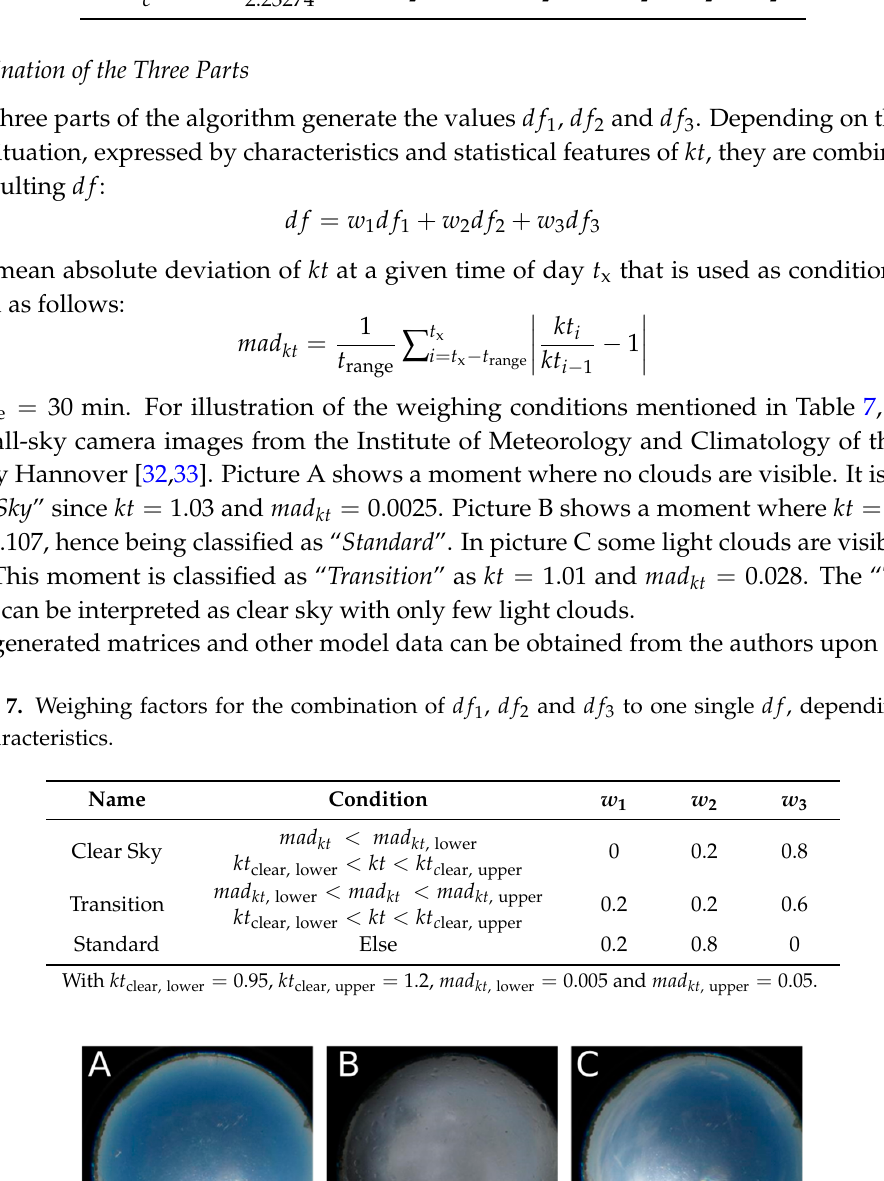
Figure 11. Three pictures made by an Hemispherical Sky Imager in Hannover (at the Institute for Meteorology and Climatology of the Leibniz University Hannover) in order to illustrate the three different weighing conditions presented in Table 7. Time in UTC. ( A ) 02 May 2016 12:00–Clear Sky: kt = 1.03, mad kt = 0.0025; ( B ) 03 May 2016 12:00–Standard: kt = 0.147, mad kt = 0.107; ( C ) 06 May 2016 09:40–Transition: kt = 1.01, mad kt =